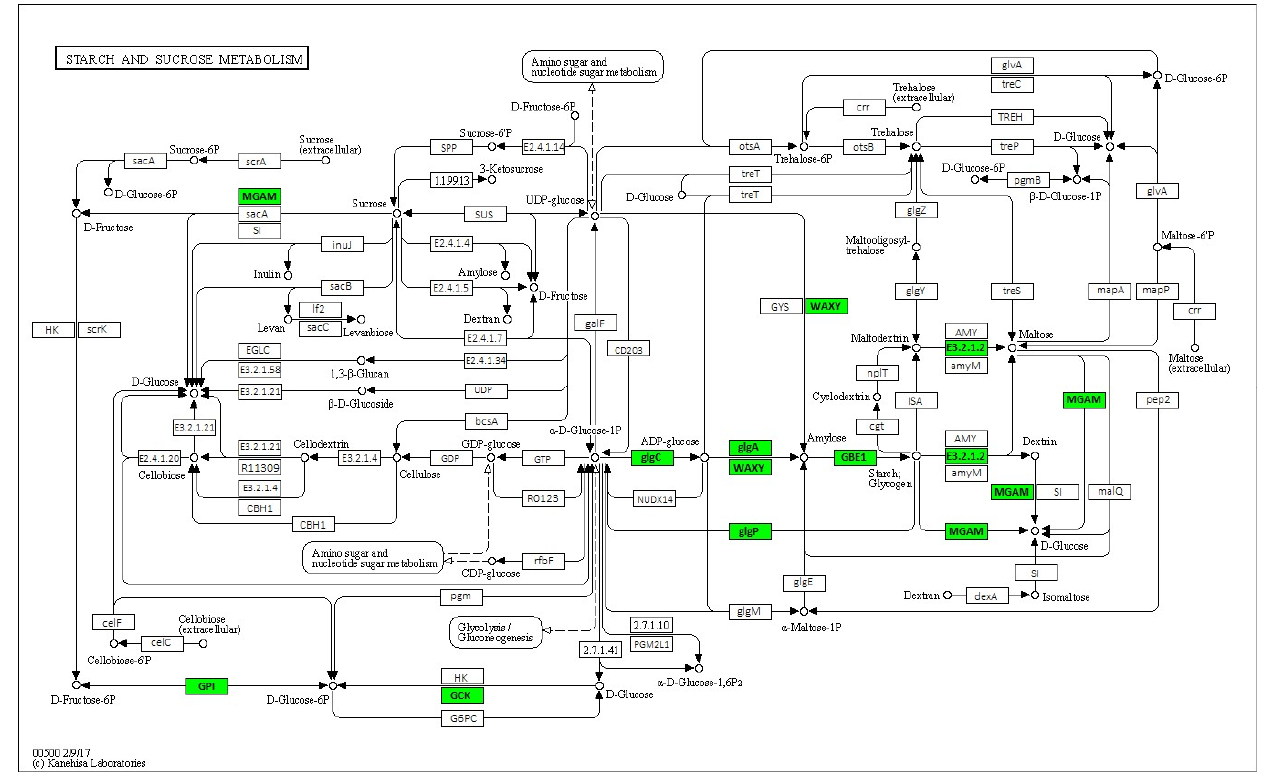
Figure 5. Transcripts related to starch and sucrose metabolism in C Las-infected Persian lime leaves. The green boxes indicate upregulated genes. The annotation was calculated with KEGG Blast Koala.